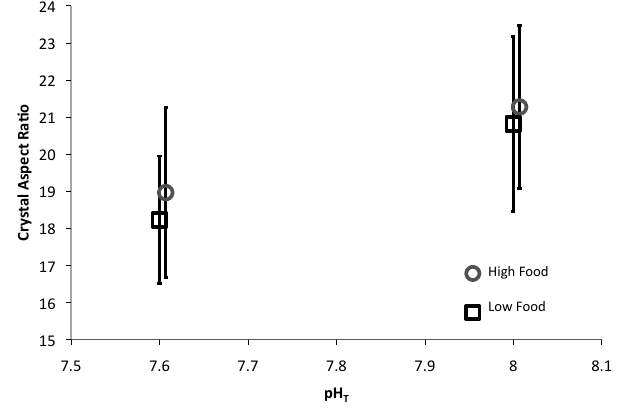
Fig. 6. Mean crystal aspect ratios ± s.d. of aragonite crystals in septa of juvenile Balanophyllia elegans , calculated by dividing the crystal length by the crystal width for individual